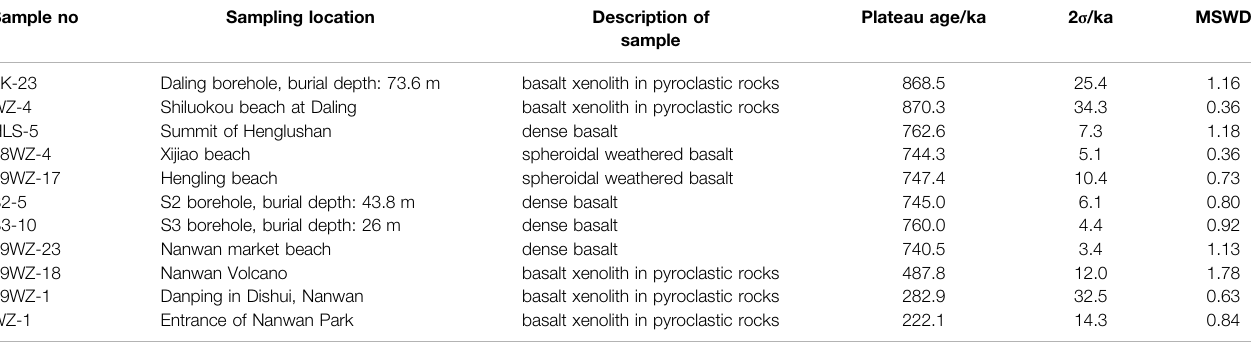
TABLE 1 | Weizhou island igneous rock samples that were used for 40 Ar/ 39 Ar dating and their ages. Sample no Sampling